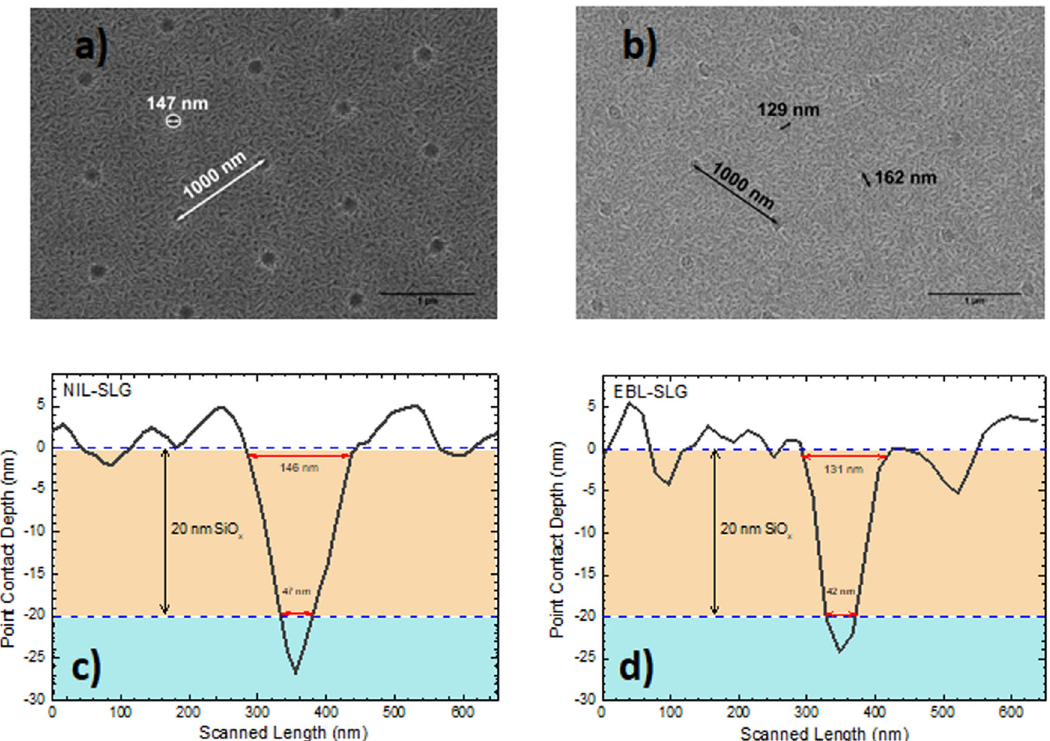
Fig. 1 Rigid substrates morphological characterization after the lithographic process. Top-view SEM images of: ( a ) NIL-SLG and ( b ) EBL-SLG substrates. The SEM images were taken with a Horizon fi eld width (HFW) of 5 µm and an acceleration voltage of 5 kV. AFM cross-section pro fi les of a representative point contact of: ( c ) NIL-SLG and ( d ) EBL-SLG substrates obtained with a scan rate of 0.5 Hz. We note that the AFM obtained distance for both substrates is within average values for the SEM